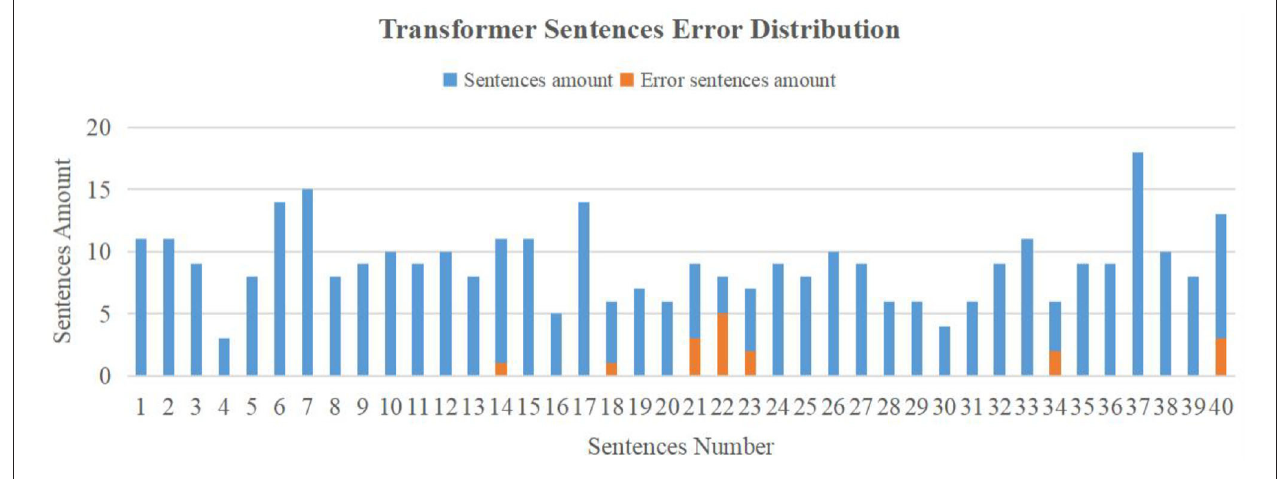
FIGURE 10 | Transformer model evaluation result.